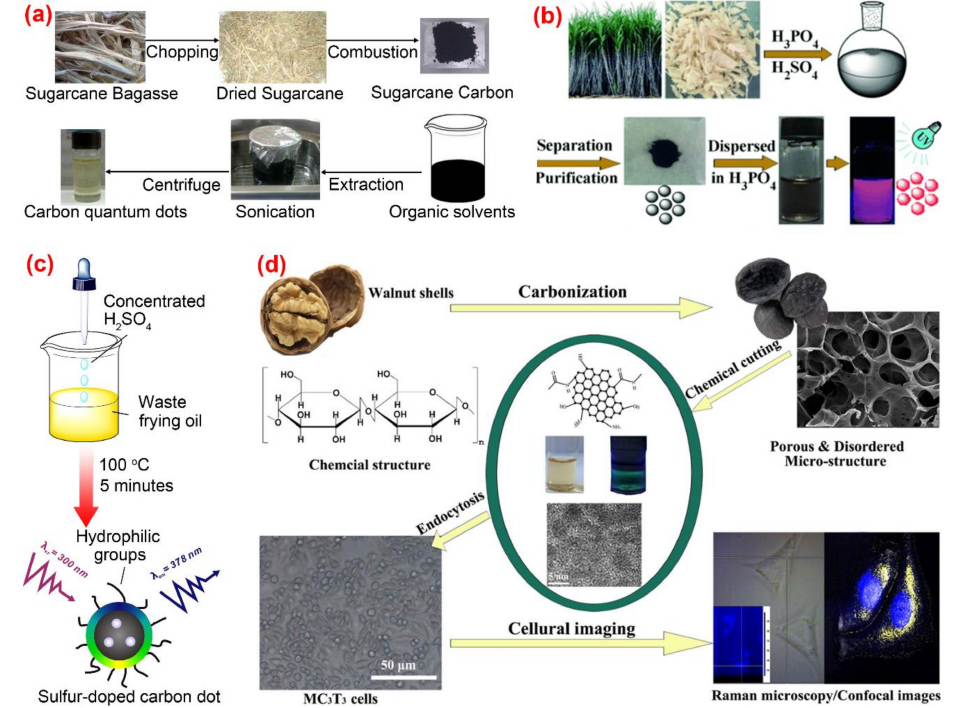
Figure 7. The preparation and application of C-dots by other synthetic methods. ( a ) The synthetic process of C-dots from sugarcane bagasse pulp [84]; ( b ) the synthesis of C-dots from bagasse [85]; ( c ) sulfur-doped carbon dots obtained from waste frying oil [86]; ( d ) the synthesis and application of C-dots from walnut shells